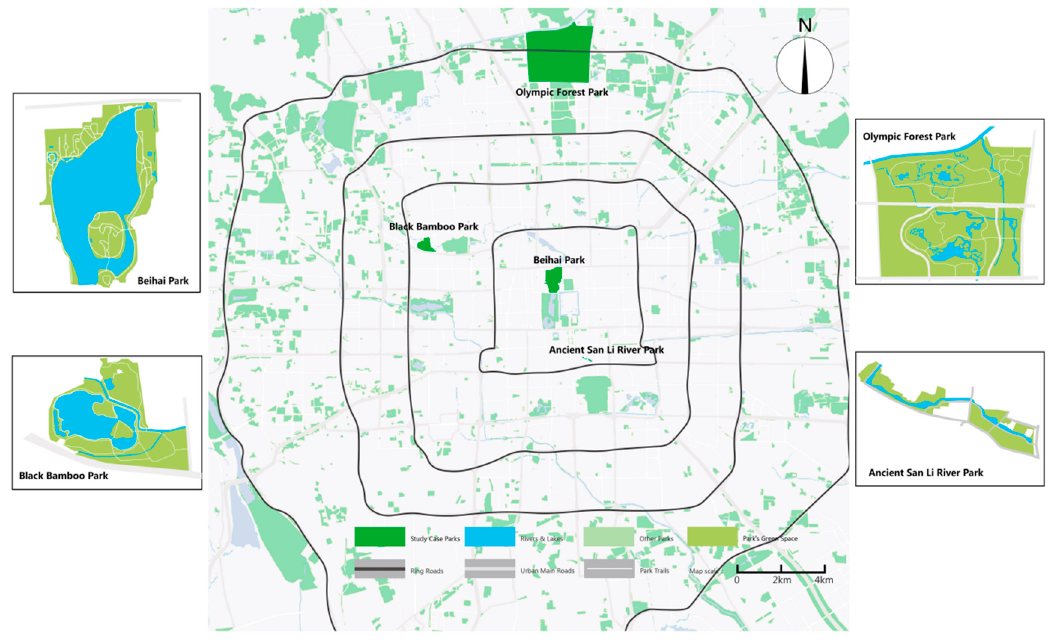
Figure 2. Location of parks used as case